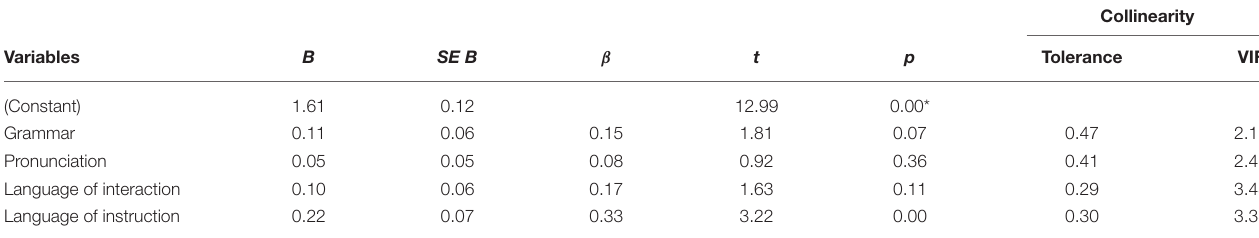
TABLE 3 | Summary of multiple regression analysis for the constructs of English proficiency (EP) predicting teaching self-efficacy (SE) ( N =